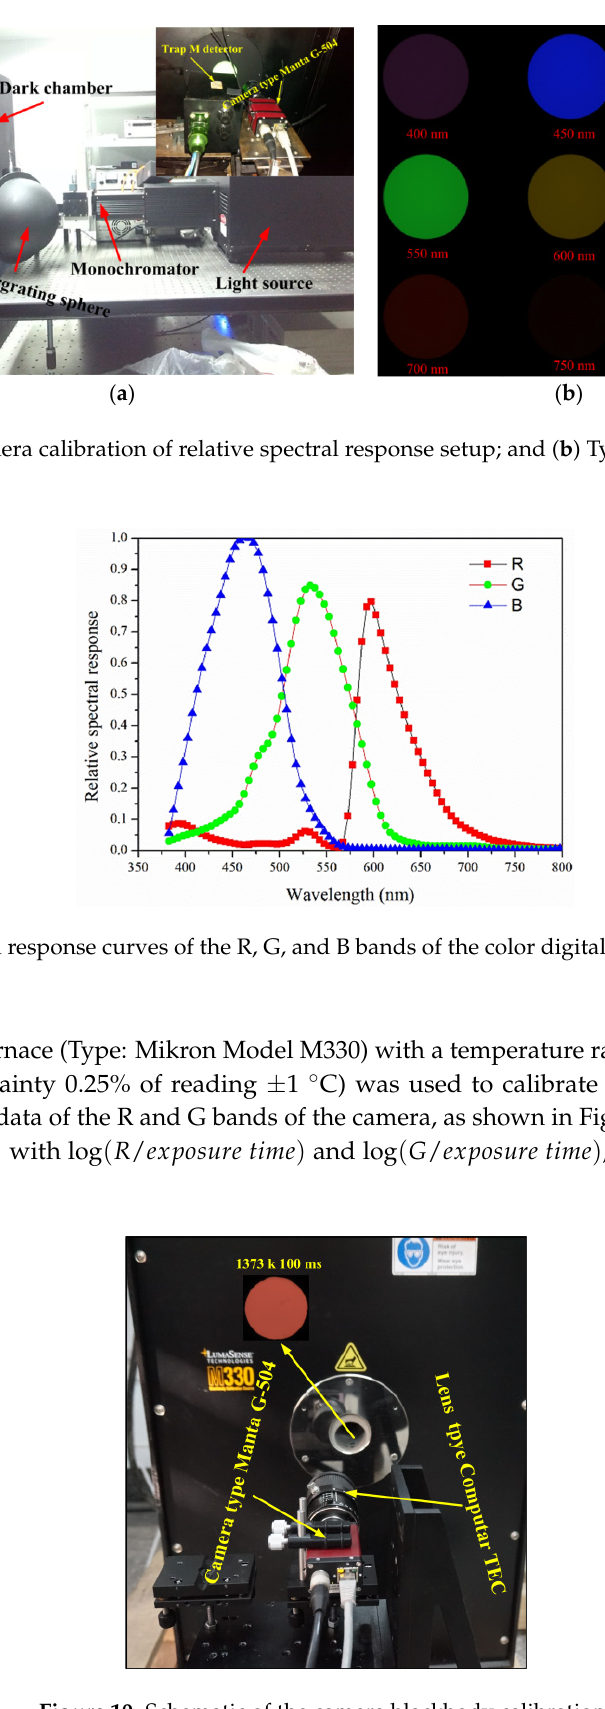
Figure 10. Schematic of the camera blackbody calibration.